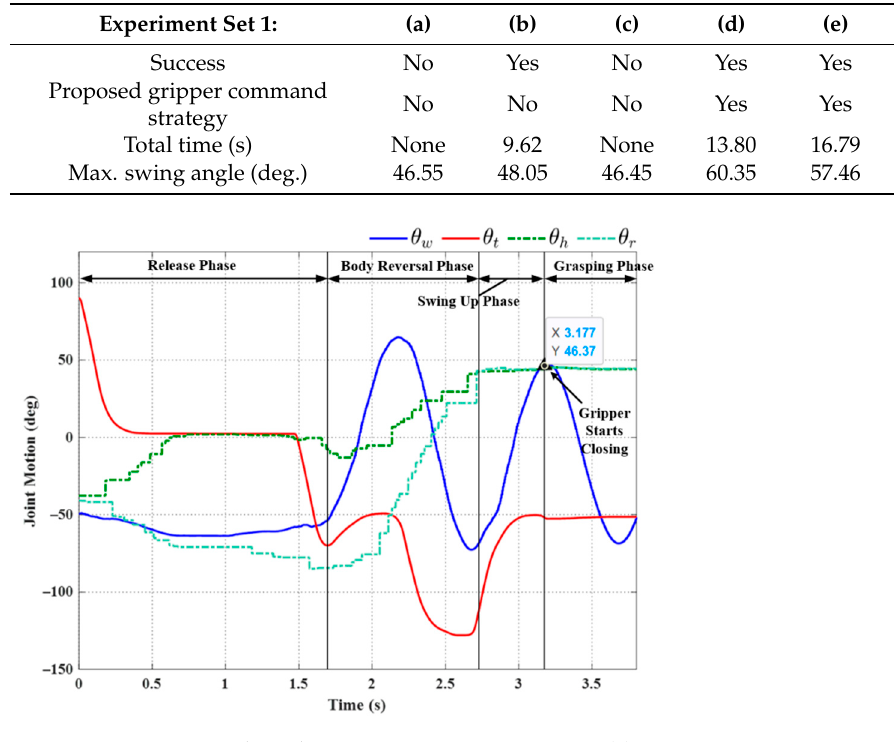
Figure 18. Experimental results: joint motion in Experiment (c).